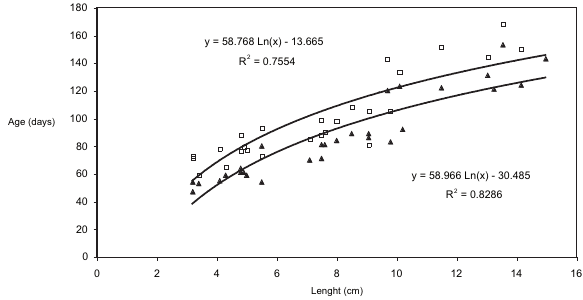
Fig . 3. – Logarithmic growth curve for European anchovy, read in the postrostrum with the two methods. GBR (triangles) n=22 and IMR (squares)